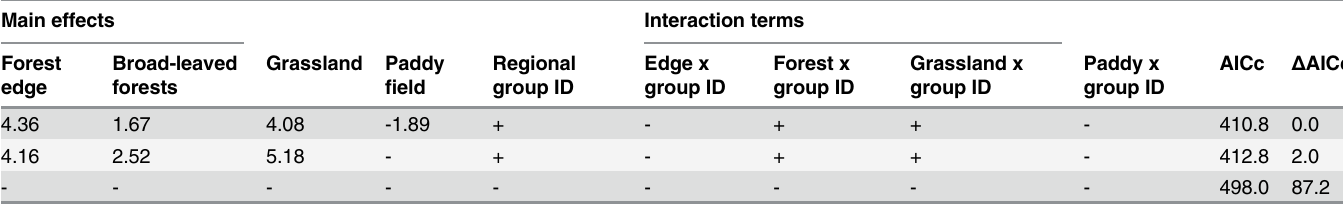
Table 1. Selected models for 3 regional groups based on prey-item similarity (southern, central and northern) to explain relationships between buzzard occurrence and landscape elements. Main